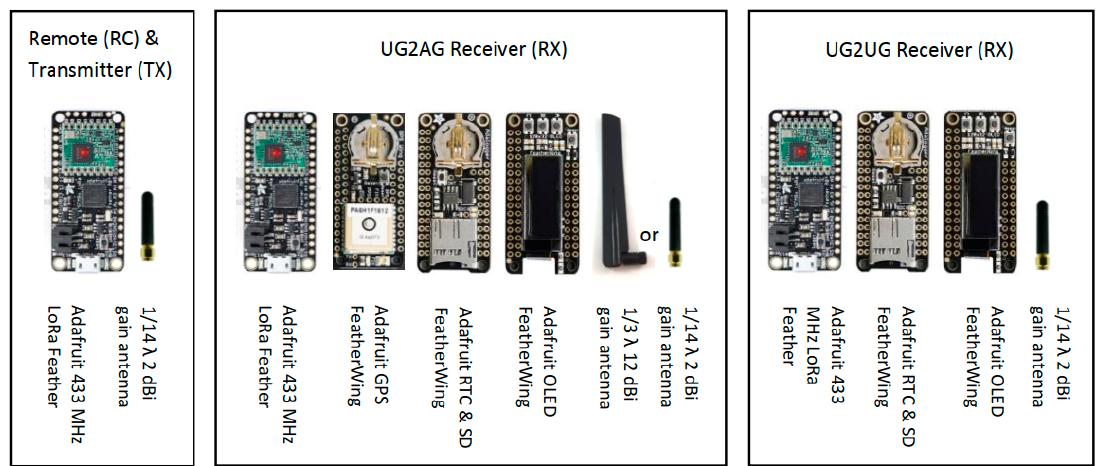
Figure 1. Hardware components for underground-to-aboveground (UG2AG) and underground-to- underground (UG2UG) nodes.